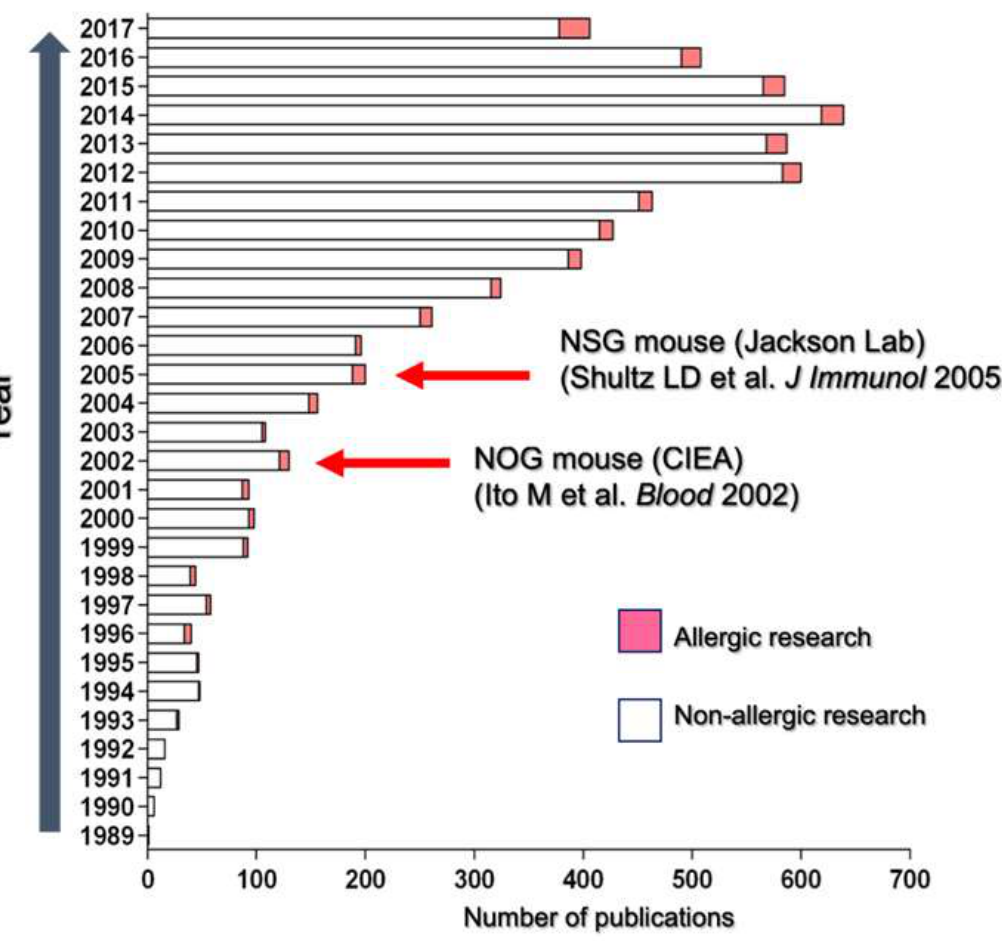
Figure 1. Publication history of humanized mouse research. The number of publications related to allergy (pink) and non-allergy (white) research using humanized mice between 1989 and 2017 are presented. Red arrows indicate the establishment of NOD-scid IL2r γ null (NOG or NSG)